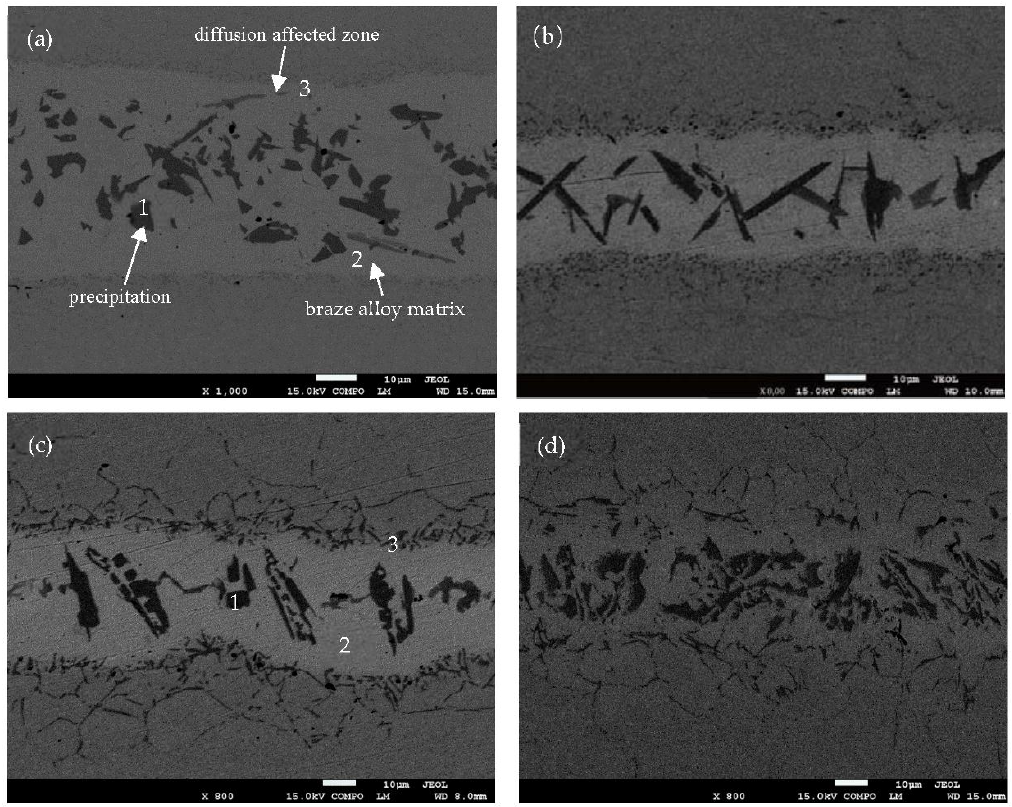
Figure 3. The SEM backscattered image of BNi-2 brazed at 1120 °C for ( a ) 10 s, ( b ) 30 s, ( c ) 50 s, ( d ) 90 s.